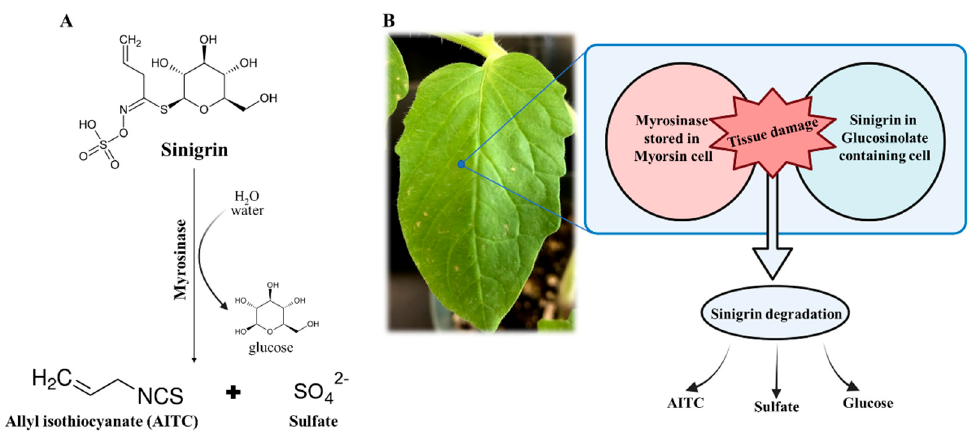
Figure 1. ( A ) Hydrolysis reaction of sinigrin catalyzed through myrosinase to produce AITC; ( B ) schematic illustration of plant tissue damage and ensuing interaction of sinigrin and myrosinase with AITC production.